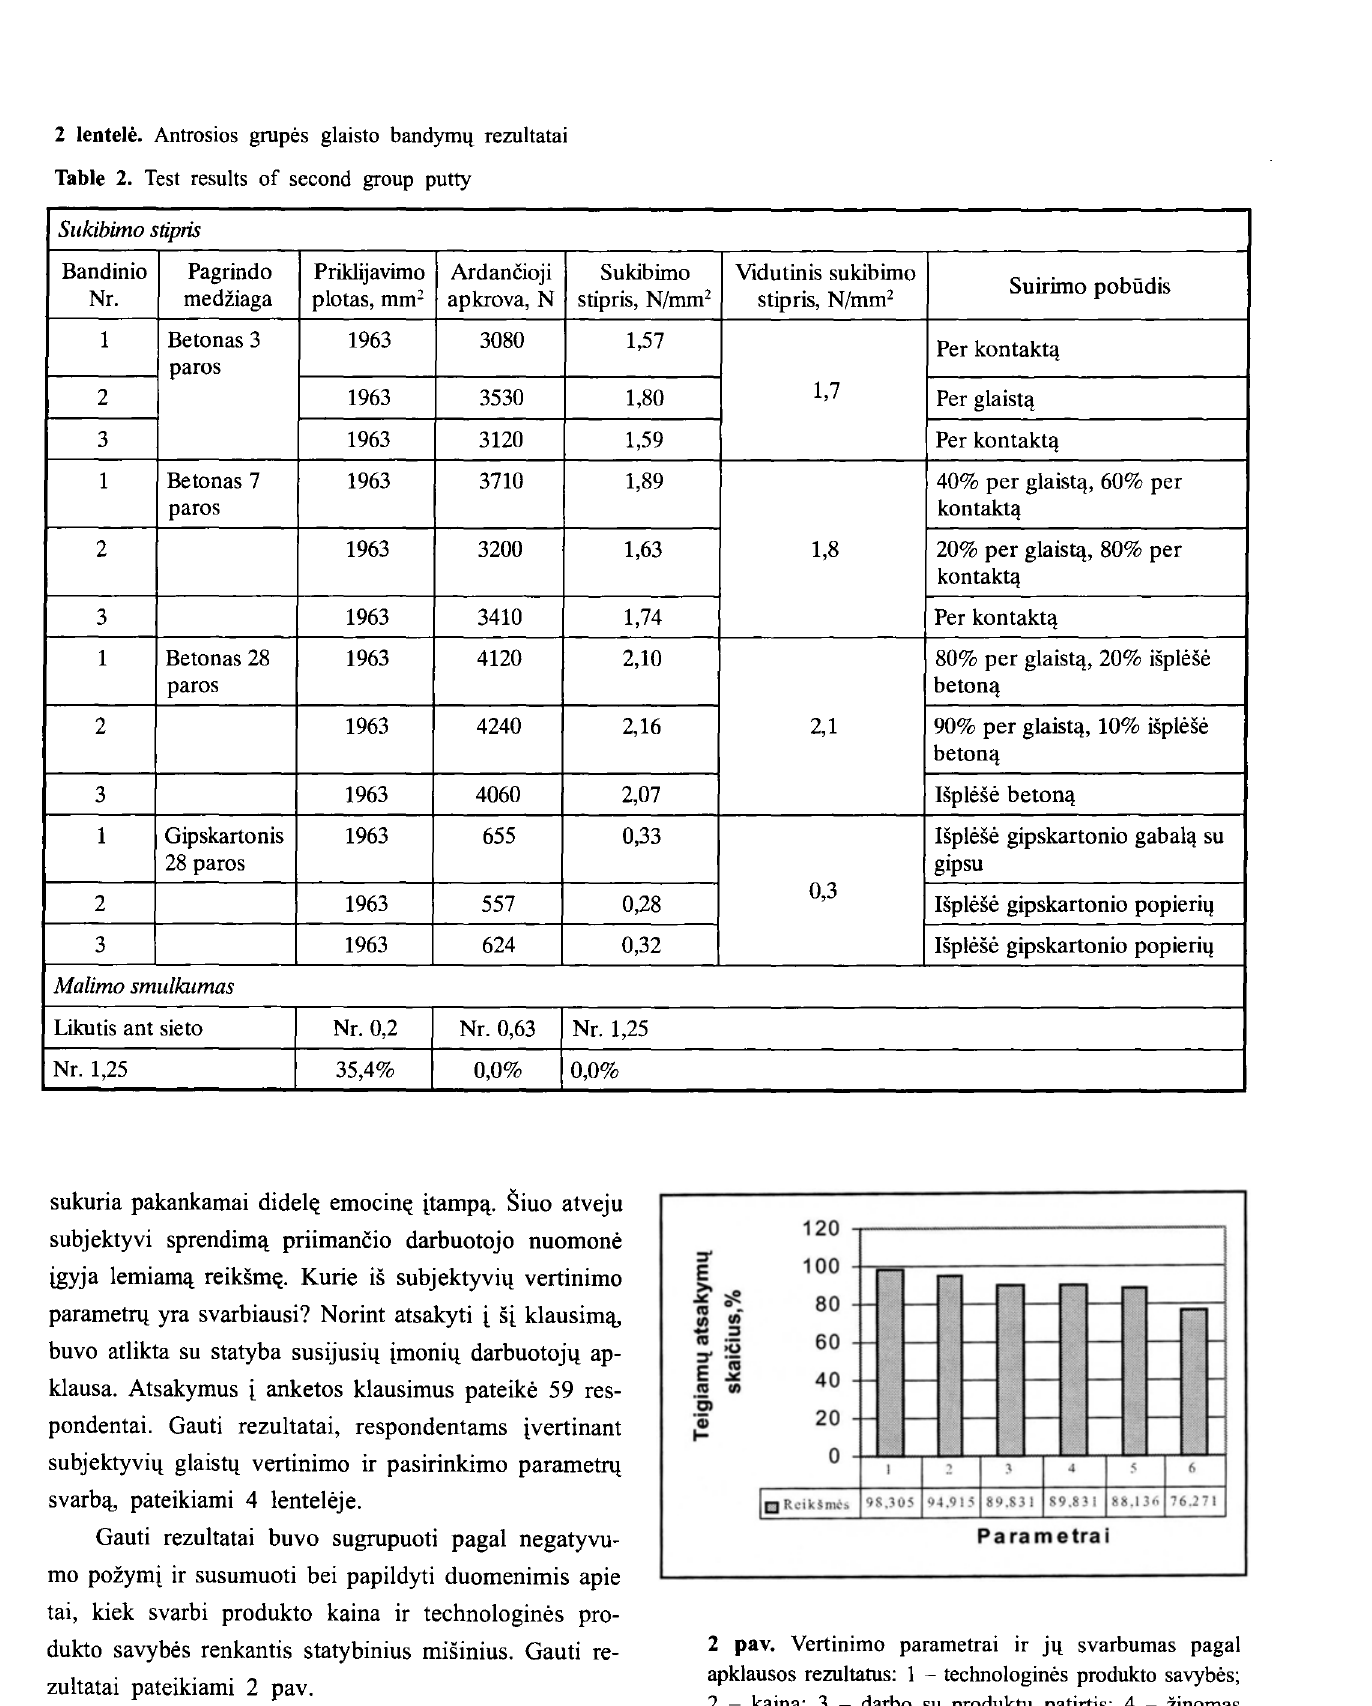
Fig 2. Evaluation indexes and significances according to the